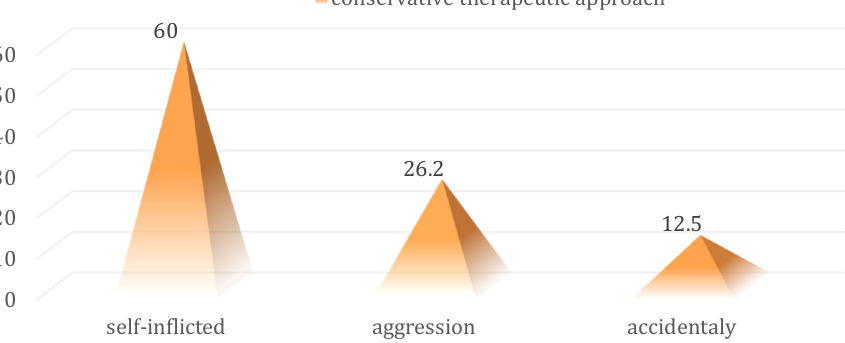
Figure 13. Distribution of cases in the batch with indications for conservative management according to the lesion mechanism.